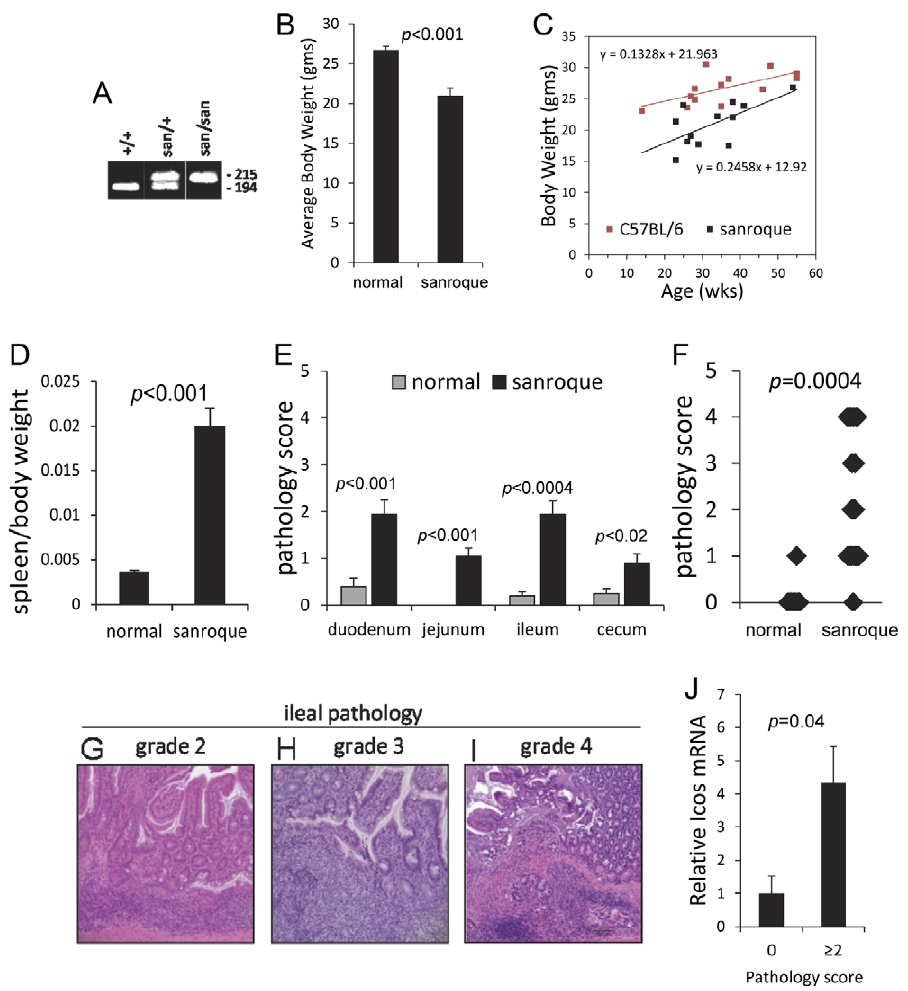
Figure 1. Morphometric and intestinal histopathological features of Roquin san/san mice. ( A ) MS-PCR was used to identify homozygous Roquin san/san mutant as demonstrated by the presence of a single 215 bp PCR product. Heterozygous Roquin san/san mice had two PCR products. Roquin san/san mice employed in the study were confirmed by MS-PCR. ( B, C ) Body weight of Roquin san/san mice 15–55 weeks of age was significantly less than that of gender-matched normal animals. Mean 6 SEM of 13 normal and 12 Roquin san/san mice. ( D ) Roquin san/san mice also had pronounced splenomegaly with follicular lymphoid hyperplasia, a characteristic of this animal model. Mean 6 SEM of 7 normal and 12 Roquin san/san mice ages 15– 55 weeks. ( E ) Histopathological analysis of intestinal tissues revealed inflammation throughout the small intestine and cecum. Mean 6 SEM of pathology scores of tissues from 23 Roquin san/san mice and 8–10 normal mice ages 15–55 weeks. ( F ) Distribution of pathology scores for the ileum of Roquin san/san mice as shown in panel E; note that only 2 of 23 Roquin san/san mice had no inflammation or mucosal injury in the ileum. ( G–I ) Representative H&E stained tissue sections from the ileum of Roquin san/san mice with pathology scores of 2, 3, and 4 that were characterized by villous atrophy and ulceration, crypt hyperplasia and increased intraepithelial mononuclear cell infiltrate. Original magnification, 200x. ( J ) Icos gene expression was elevated in the ileum of Roquin san/san mice. Mean 6 SEM of three replicate samples ages 16, 17, and 26 weeks.